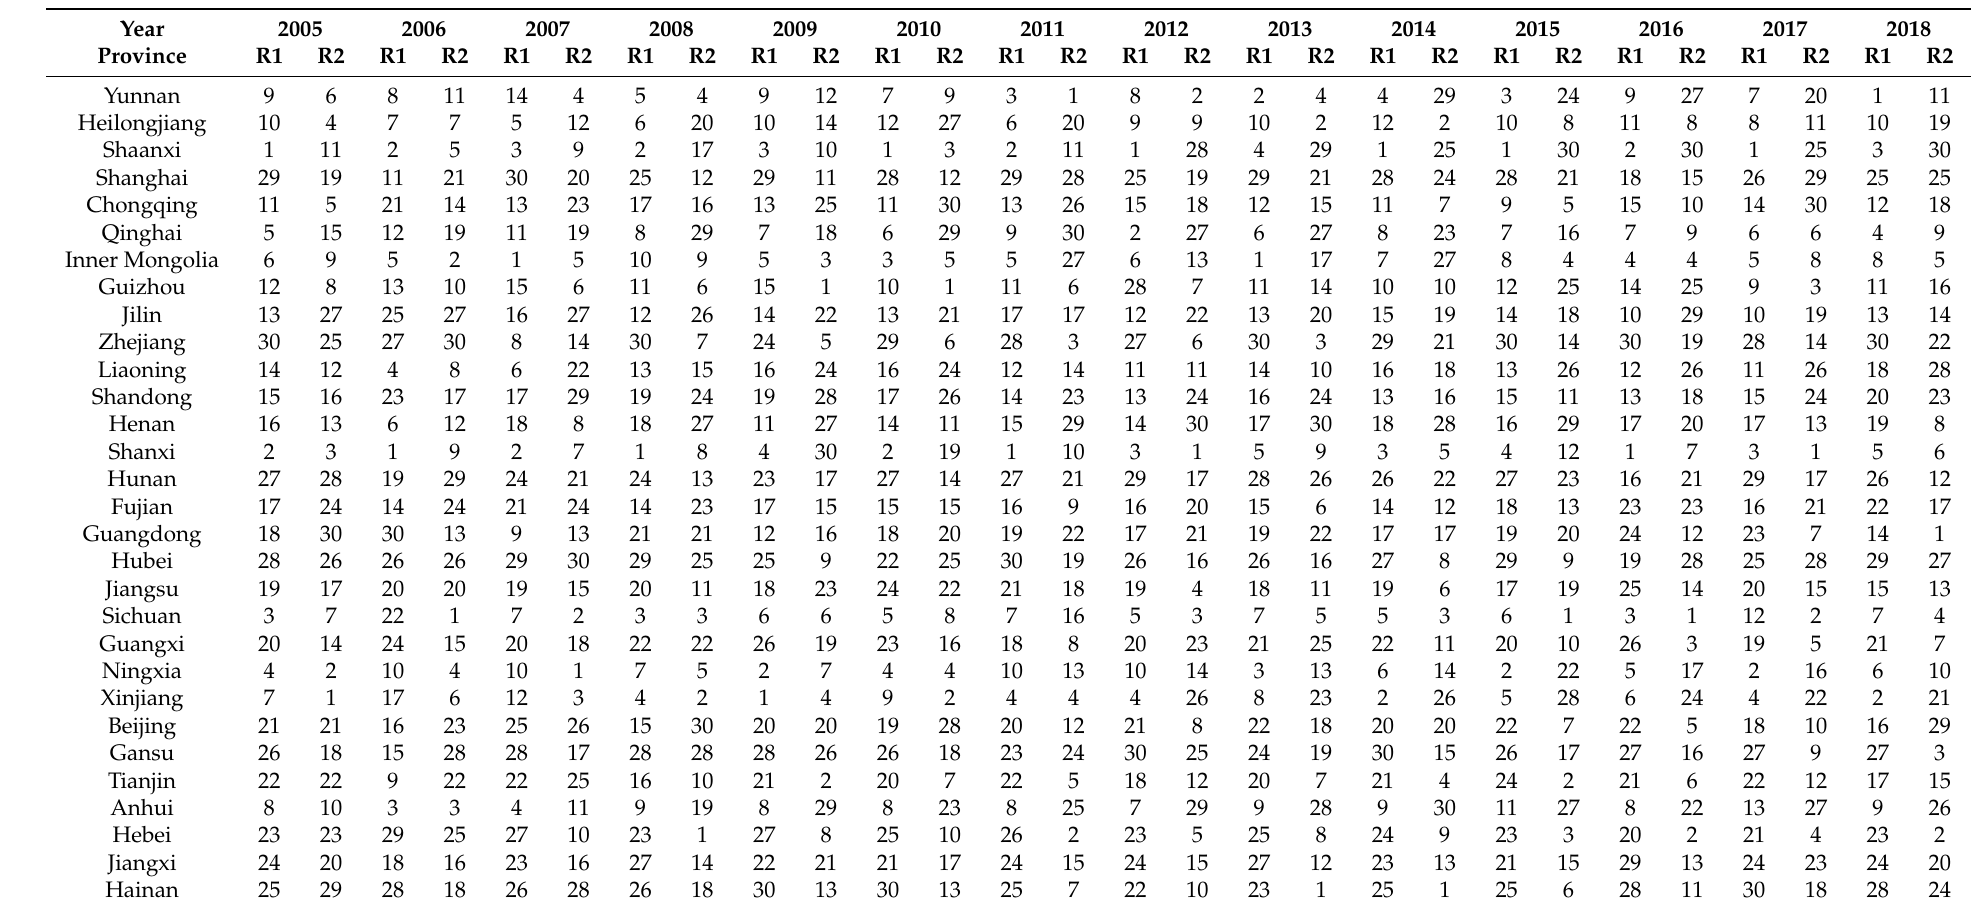
Table 3. Energy resilience ranking of each province in China by comparison of two gray relational